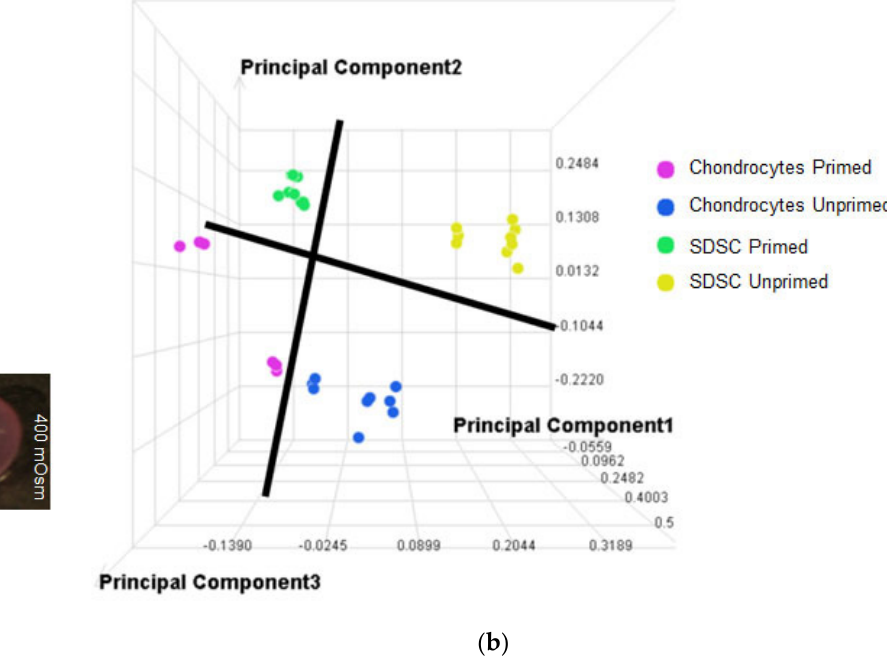
Figure 3. ( a ) Glycosaminoglycan (GAG) content of SDSC micropellet cultures was promoted by physiologic hypertonic media (400 mOsm) relative to isotonic media (330 mOsm), similar to that reported for SDSCs in 3D hydrogel culture [28]. * p < 0.05 vs D0; ** p < 0.05 vs other groups (n = 3–4/group). Scale bar: 1mm. ( b ) Principal component analysis of Z-score transformed intensity data processed by the Elucidator program for the 33 LC/MS chromatograms performed in a study [25] where canine SDSCs were primed in culture media containing (1 ng/mL TGF- β 1, 5 ng/mL bFGF, and 10 ng/mL PDGF-BB). Each data point represents a chromatogram. Data from unprimed cells are found on the right side of the first principal component axis. Data from primed cells are grouped on the left side of that axis, suggesting an overall global effect of the growth factor priming. The distance between unprimed and primed chromatograms was greater for SDSCs than for chondro- cytes, suggesting that priming yielded a more pronounced effect for SDSCs. Unpublished data from Dr. Hung’s laboratory.